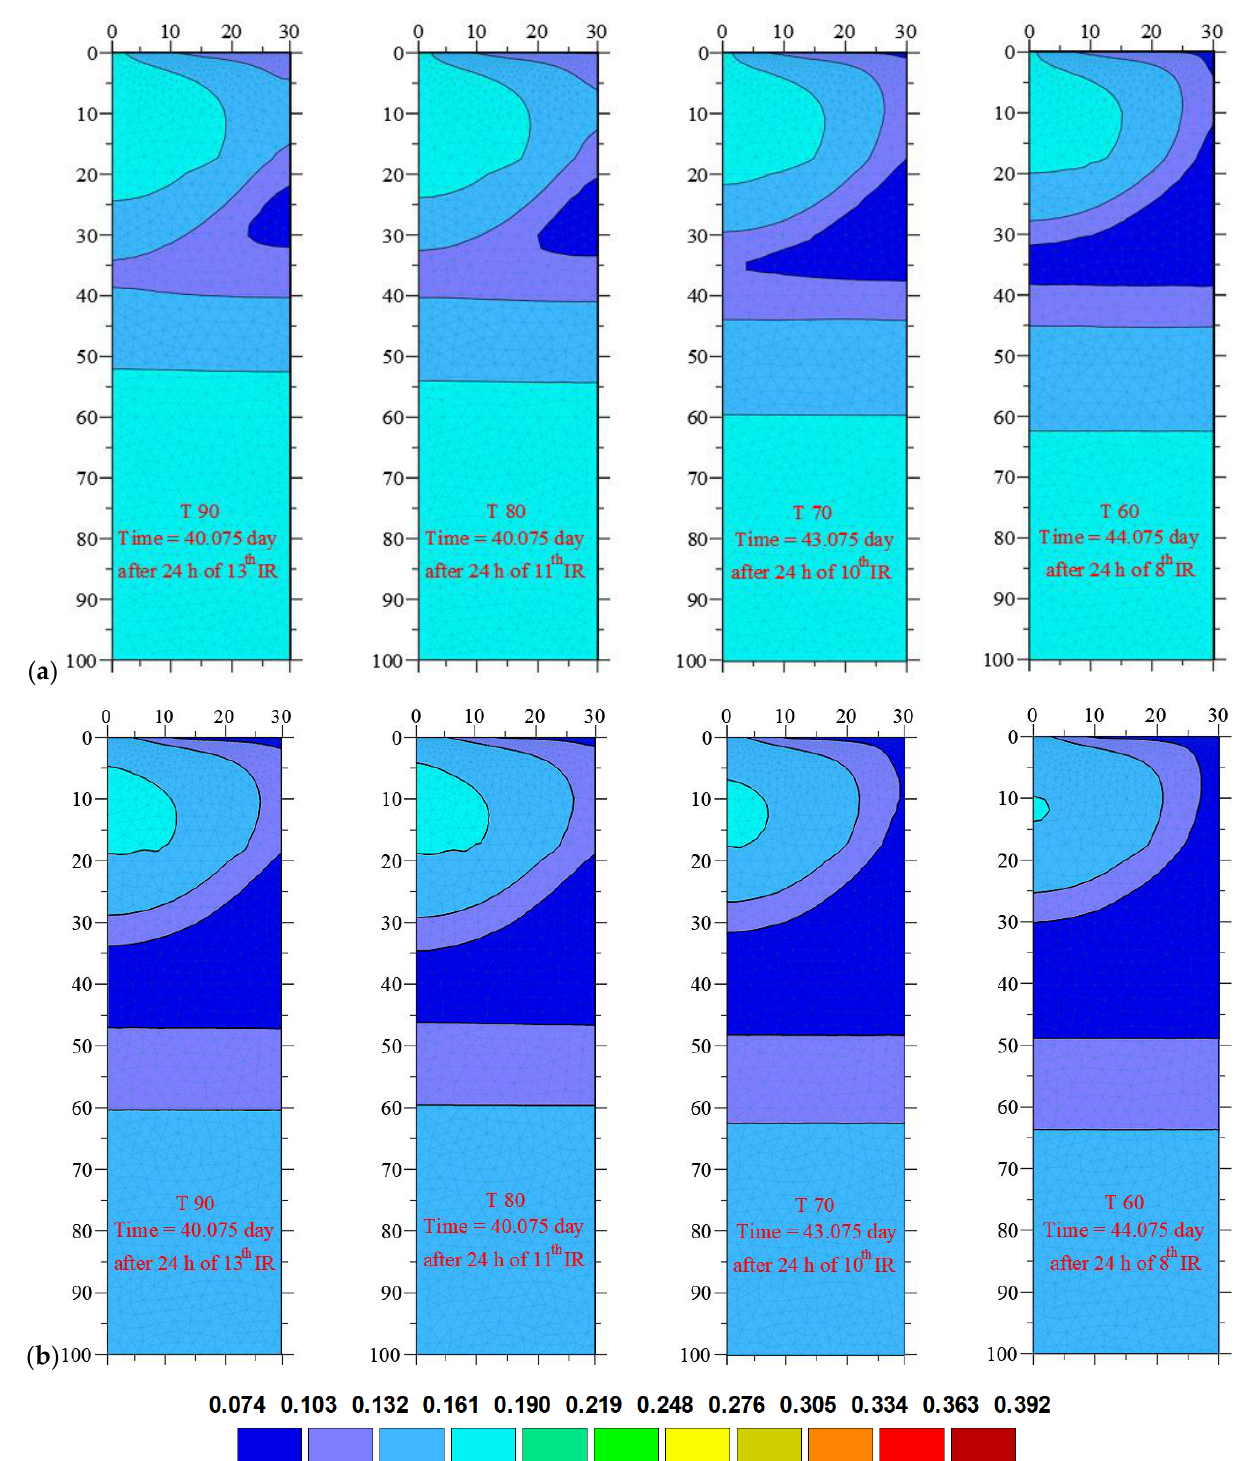
Figure 3. SWC distribution after 24 h from the middle irrigation event for the four irrigation treatments, ( a ) considered root growth, and ( b ) constant average root depth (no growth) during the growing season.